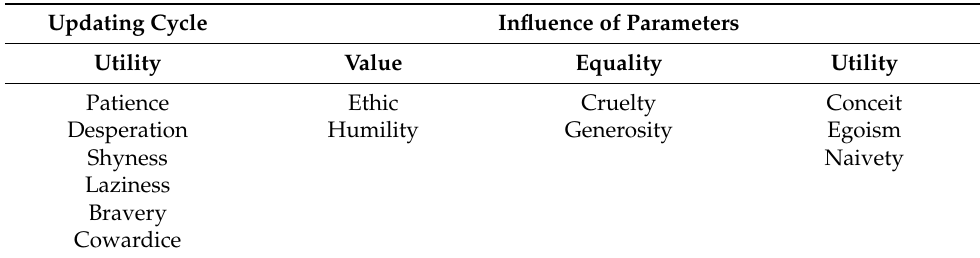
Table 1. Classification of personality